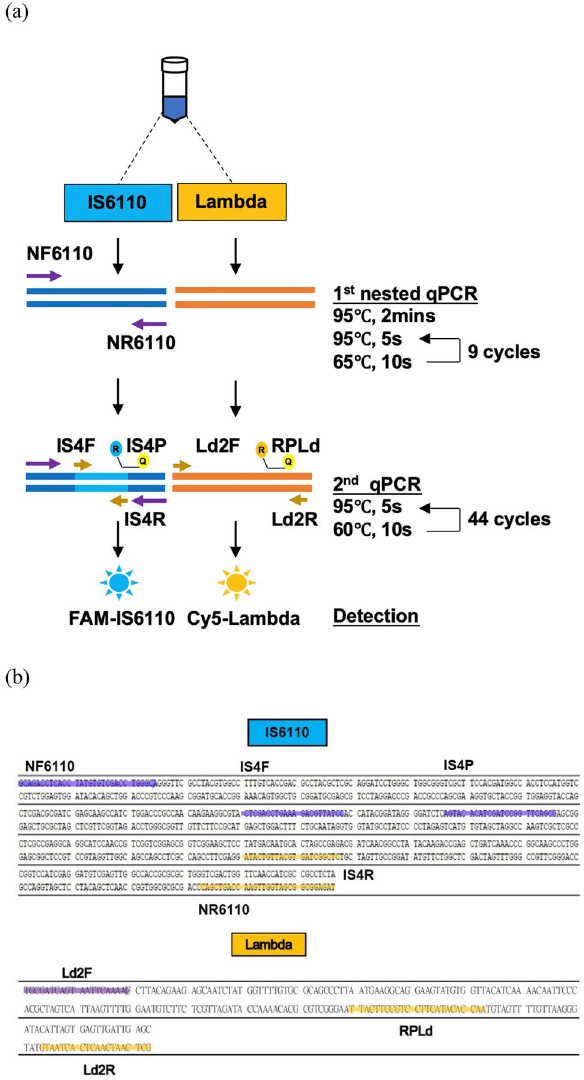
Figure 1. Schematic representation of the single-tube nested real-time PCR amplification and sequences of primers/probes. ( a ) Schematic showing how the single-tube nested qPCR works. At the first round, the PCR was performed to amplify a 428-bp fragment with an external primer set (NF6110 and NR6110). The larger amplicon produced by the first round of PCR was used as a template for the second round of PCR. The second pair of primers and probe (IS4F, IS4R and IS4P) bind within the first round of amplicon to produce a fragment shorter in length (141-bp). Second round amplicons were detection with a FAM-labeled probe (495–520 nm). The internal control (Lambda phage DNA) is only co-amplified with target DNA (IS6110-containing vector) with Ld2F, Ld2R and RPLd at the second round of PCR and the products were detection with a Cy5-labeled probe (646-662 nm). The PCR program of the assay was shown in the right-hand side. ( b ) The nested-qPCR amplicon of IS6110 from MTBC and Lambda nucleotide sequences are shown. The sense primers were shown as black letters on a purple background and the anti-sense primers were indicated as black letters on an orange